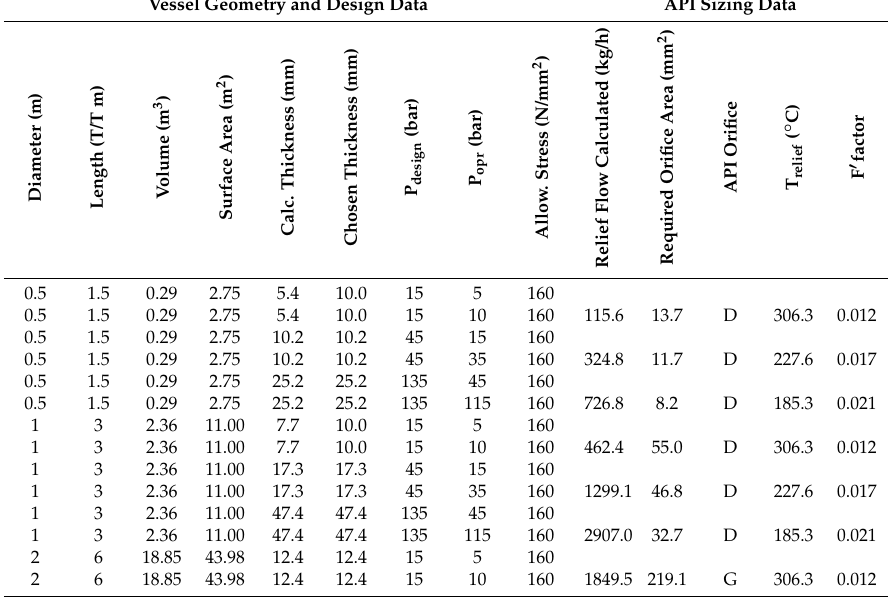
Table 3. Calculation matrix with steady-state API 521 relief valve sizing. Twenty-one percent overpressure has been applied in the sizing. Relief valve sizing has only been performed for cases with high operating pressure. For cases with low operating pressure, the margin to the design pressure/relief pressure results in the relief temperature exceeds the maximum wall